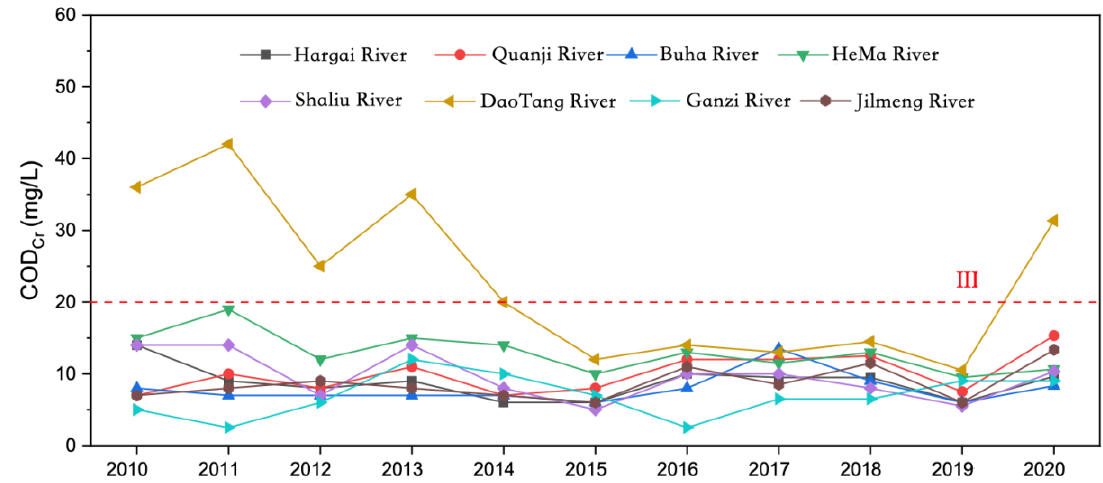
Figure 7. Change trend of COD Cr in the water bodies of rivers entering the lake from 2010 to 2020. From 2010 to 2020, the permanganate index of the main rivers entering the lake in Qinghai Lake Basin was between 1.44 and 2.98 mg/L, with an average of 2.18 mg/L (Figure 8); The permanganate index of the rivers entering the lake was lower than that of the lake as a whole.